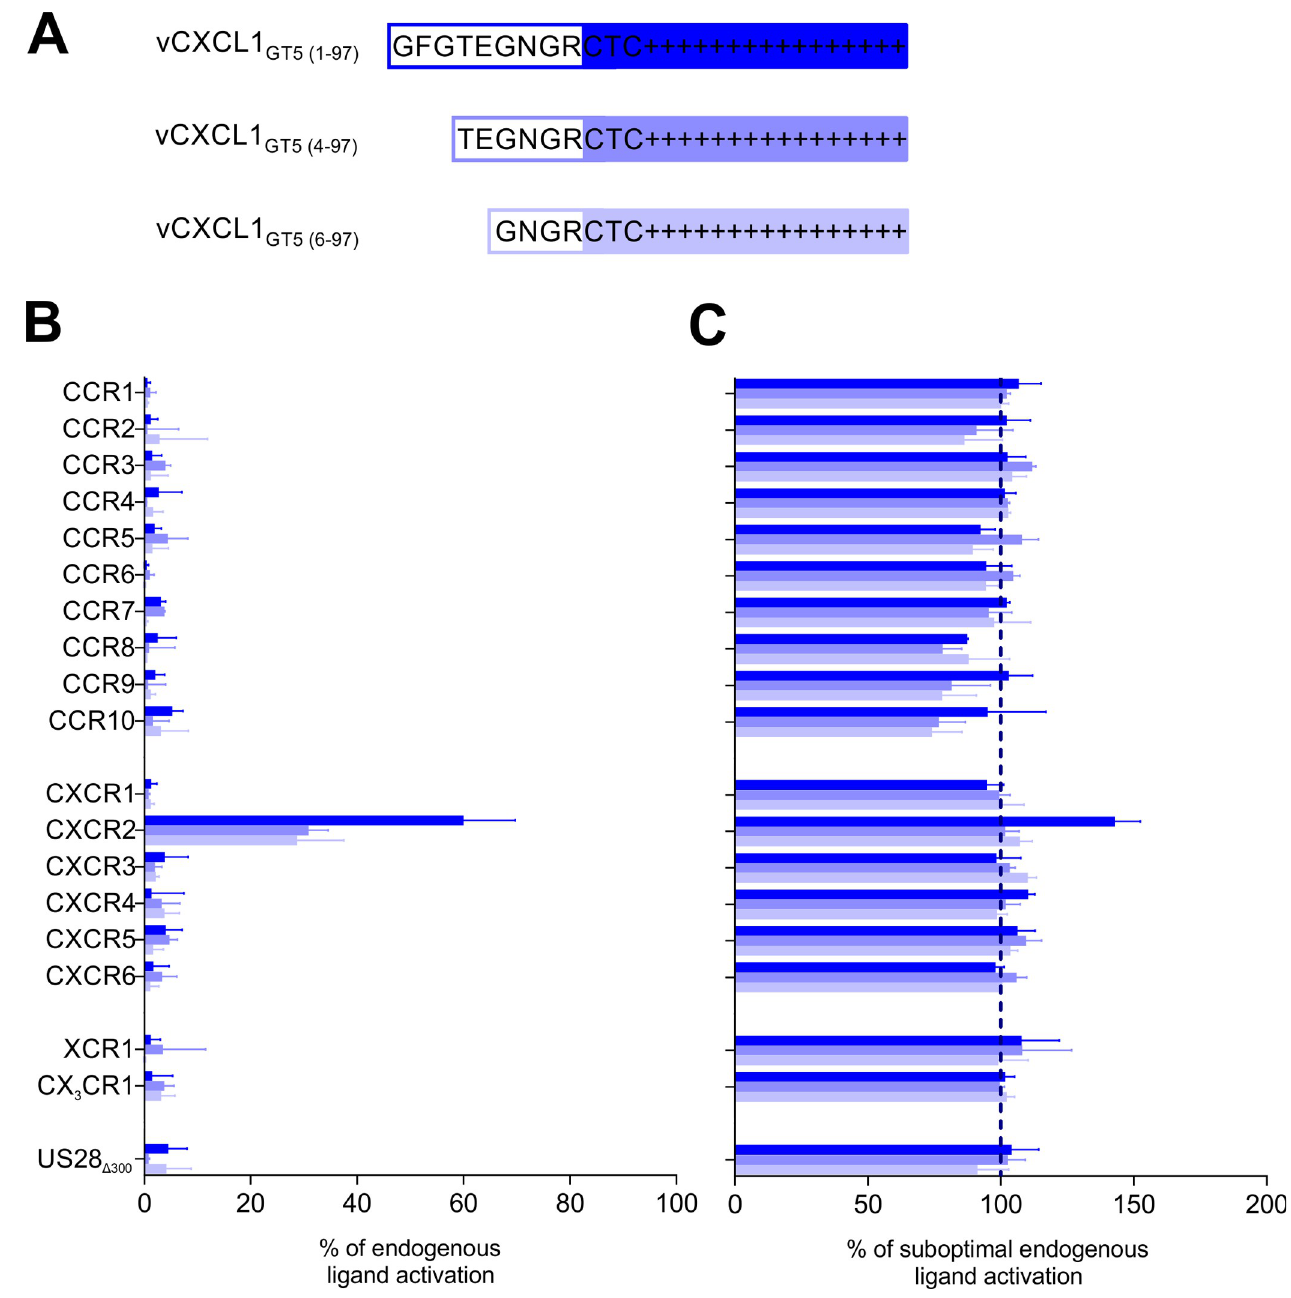
Fig 4. Screening of non-ELR vCXCL1 GT5 activity on G protein signaling of an array of all 18 classical human chemokine receptors and the HCMV- encoded US28. (A) N-terminal sequences of the wild-type and truncated versions of vCXCL1 GT5 . (B) Agonism of 1 μ M wild-type vCXCL1 GT5 , vCXCL1 GT5 (4– 97) , and vCXCL1 GT5 (6–97) on chemokine receptor G protein signaling in an IP accumulation assay compared to the response of the endogenous ligand for the receptor. The following endogenous chemokines were used as a positive control (concentrations shown in brackets): CCR1;CCL5 (B: 100 nM, C: 10 nM), CCR2;CCL7 (B: 100 nM, C: 10 nM), CCR3;CCL11 (B: 100 nM, C: 10 nM), CCR4;CCL17 (B: 100 nM, C: 10 nM), CCR5;CCL5 (B: 100 nM, C: 10 nM), CCR6; CCL20 (B: 100 nM, C: 1 nM), CCR7;CCL19 (B: 100 nM, C: 10 nM), CCR8;CCL1 (B: 100 nM, C: 10 nM), CCR9;CCL25 (B: 100 nM, C: 10 nM), CCR10;CCL27 (B: 100 nM, C: 10 nM), CXCR1;CXCL8 (B: 1 μ M, C: 10 nM), CXCR2;CXCL8 (B: 1 μ M, C: 100 nM), CXCR3;CXCL11 (B: 100 nM, C: 10 nM), CXCR4;CXCL12 (B: 100 nM, C: 10 nM), CXCR5;CXCL13 (B: 100 nM, C: 10 nM), CXCR6;CXCL16 (B: 100 nM, C: 1 nM), XCR1;XCL1 (B: 100 nM, C: 100 nM), CX 3 CR1; CX 3 CL1 (B: 100 nM, C: 1 nM), US28 Δ 300 ;CX 3 CL1 (B: 100 nM, C: 1 nM); n = 3–6. All error bars are presented as SEM. (C) Antagonism of 1 μ M wild-type